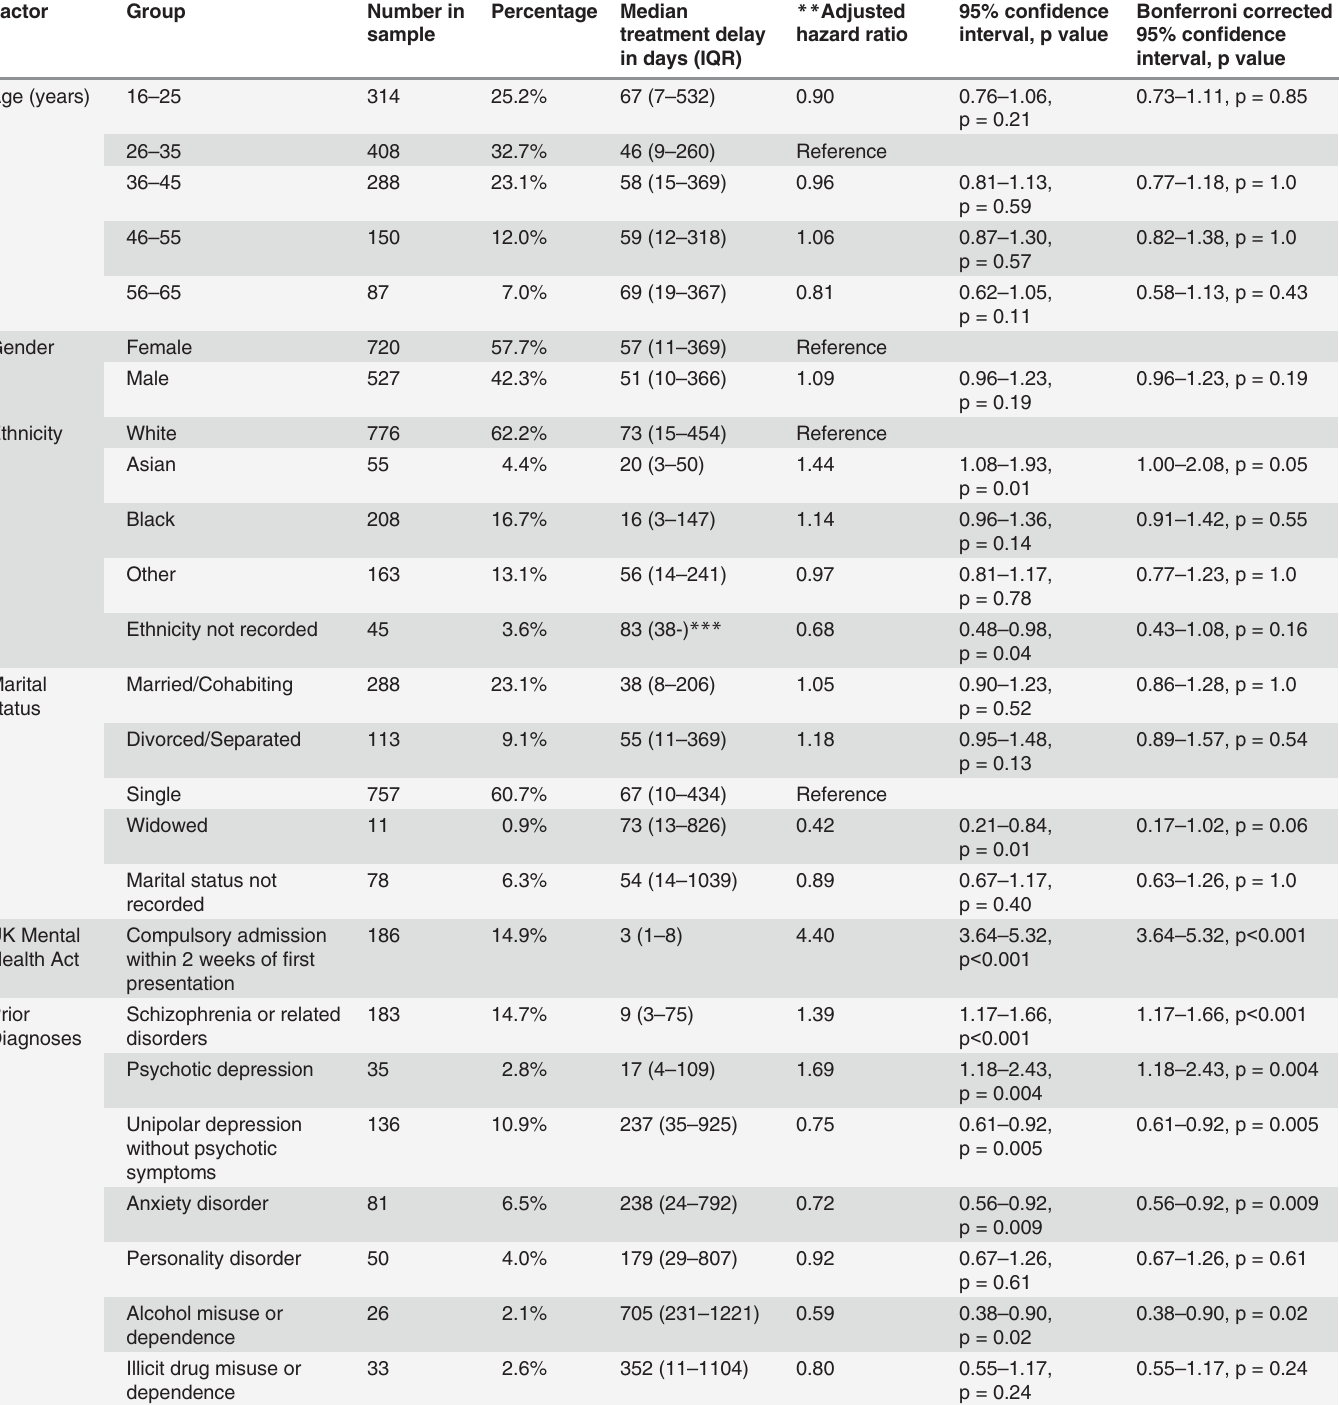
Table 5. Factors associated with bipolar disorder treatment delay (n = 1247) *